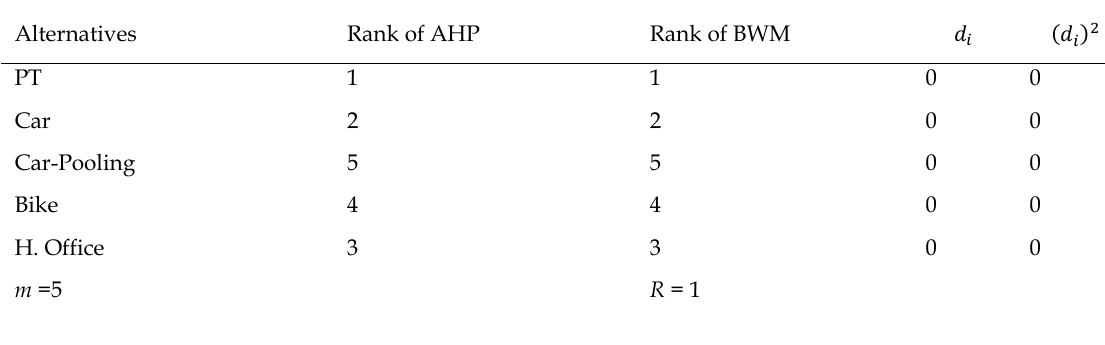
Spearman’s rank correlation coefficient for Group